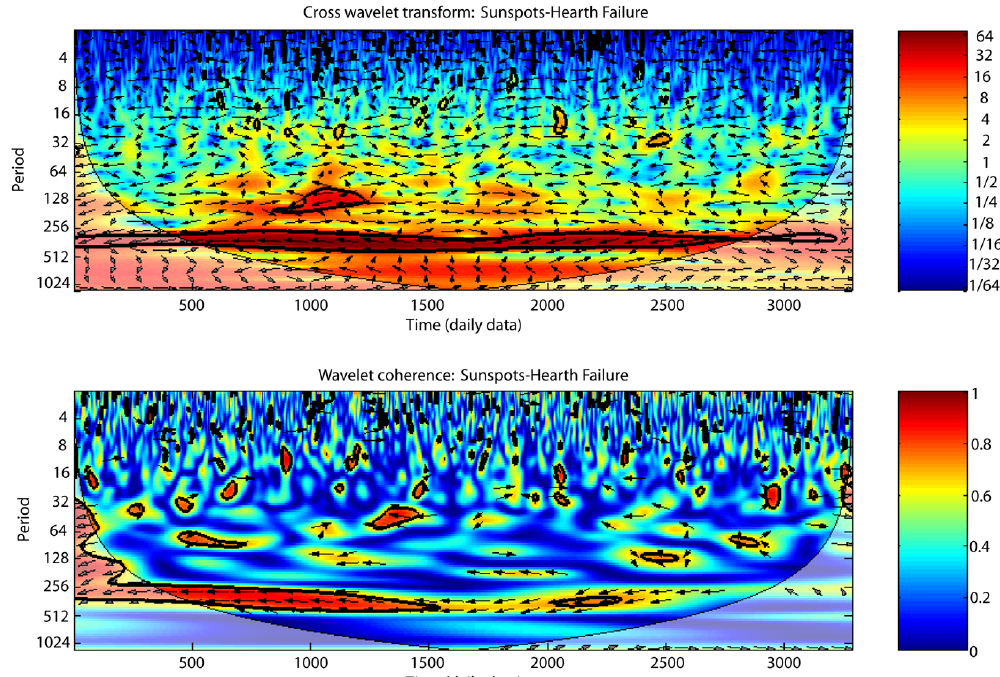
Fig. 3. Cross wavelet and wavelet coherence analysis of sunspots and HF group.